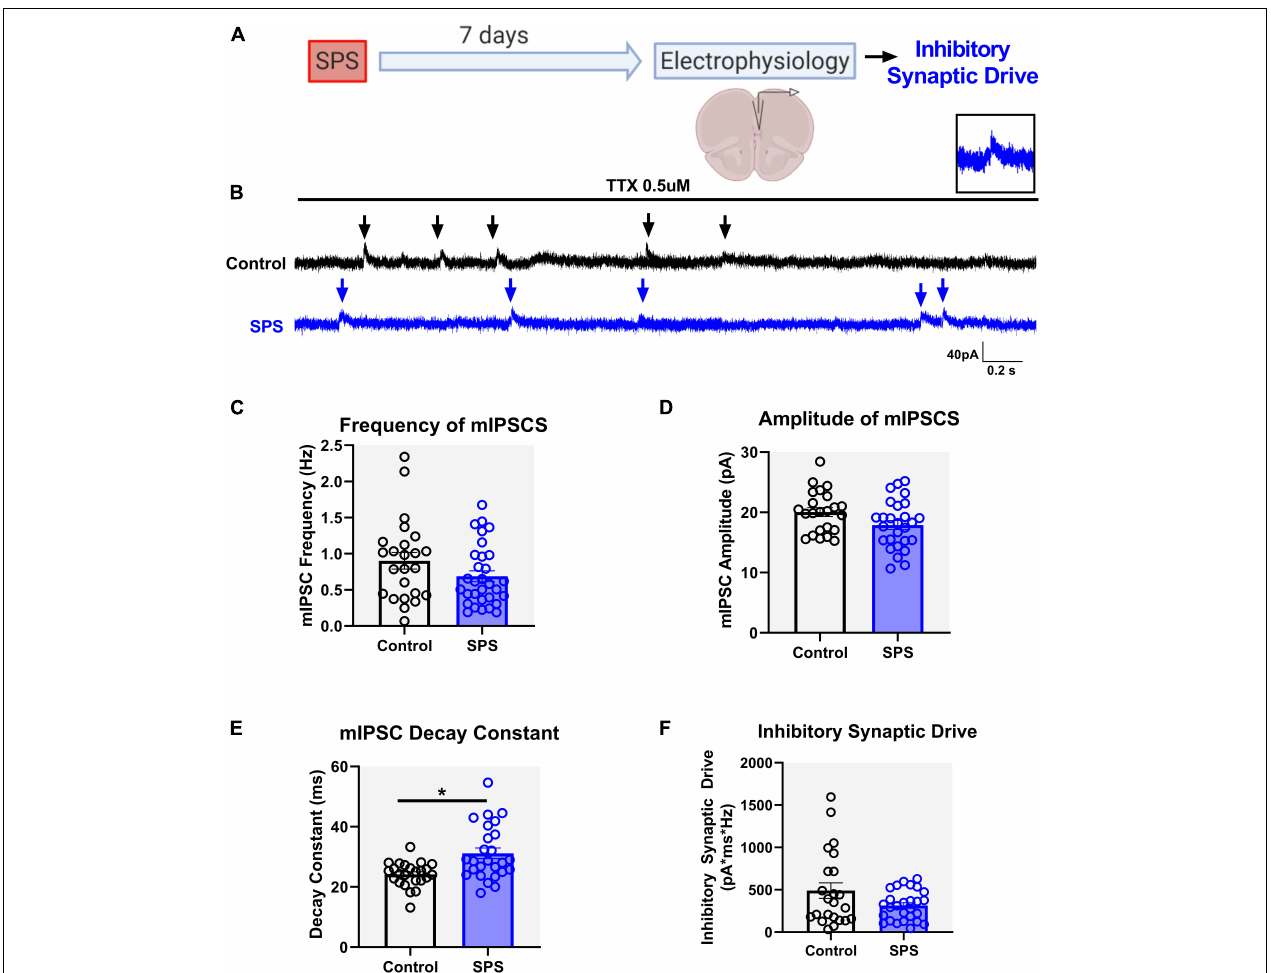
FIGURE 3 | SPS prolongs the decay of GABA currents but has no effect on overall spontaneous inhibitory synaptic drive in the IL. Schematic of the experimental timeline (A) . Electrophysiological recordings in the voltage clamp mode were obtained from the IL mPFC in male rats 7 days post SPS. Representative voltage clamp mIPSC traces of control (black) and SPS (blue) groups are shown in (B) . Arrows indicate mIPSC events. Scale bars: 40 pA, 0.2 s. Magnified image of a single mIPSC event is shown on top right (B) . SPS has no effect on mIPSC frequency (C) [ t (49) = 1.6, p = 0.1] or mIPSC amplitude (D) [ t (48) = 2.0, p = 0.05]. SPS increases the mIPSC decay (E) [ t (48) = 3.5, p < 0.01] but has no effect on inhibitory synaptic drive (F) (Mann–Whitney U = 263, p = 0.3). Data presented as Mean ± SEM. * indicates p < 0.05. n = 23–27 cells from three rats in each